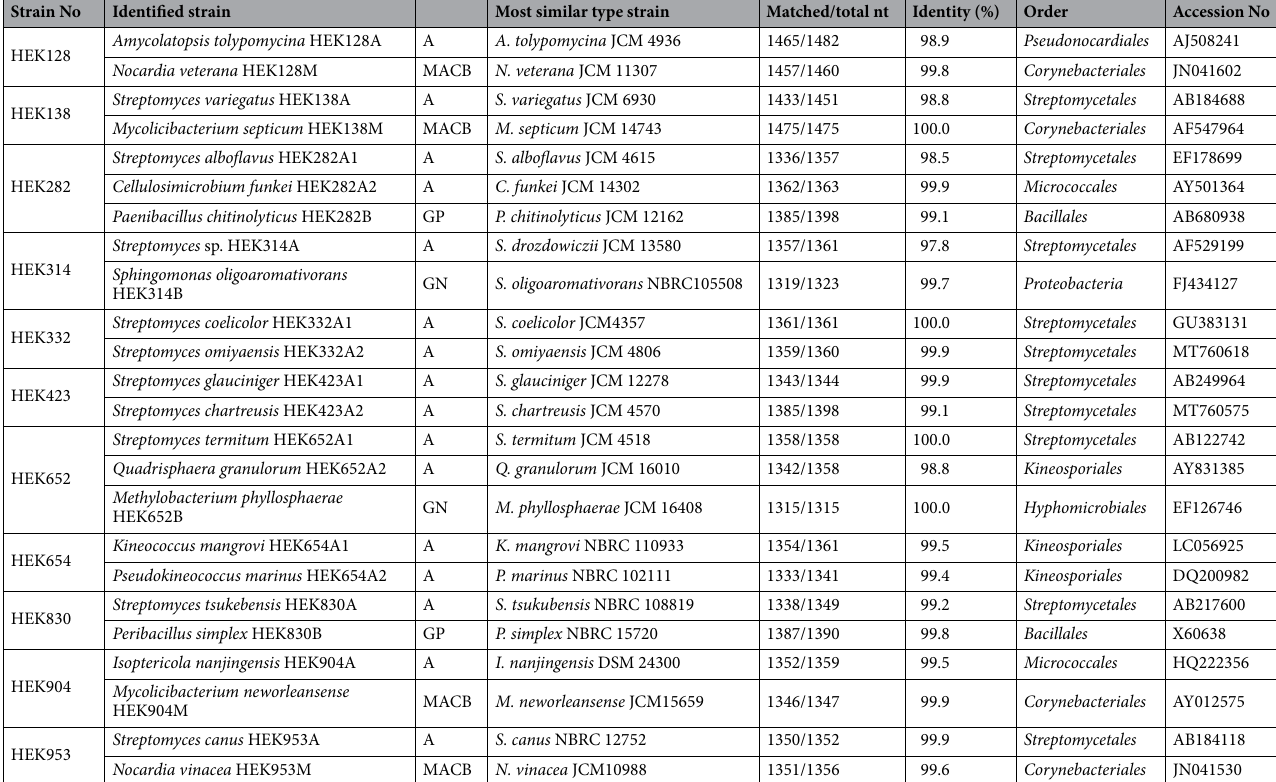
Table 1. Identification of strains from co-isolated colonies. FA , filamentous actinomycetes; MACB , mycolic acid-containing bacteria; CA , cocci-shaped actinomycetes; GP , Gram-positive bacteria; GN , Gram-negative bacteria; A , actinomycetes. Accession numbers are of the most similar type